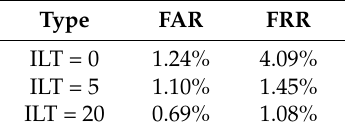
Table 3. FAR and FRR scores for different incremental learning times (ILT).